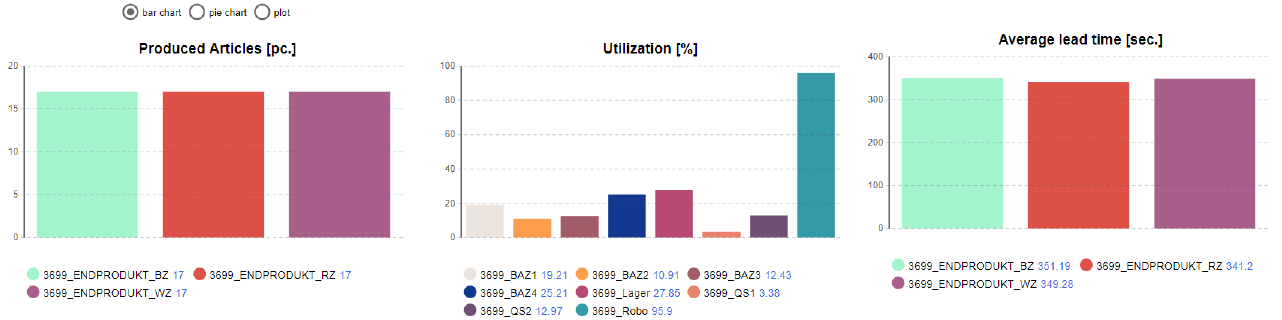
Figure 10. Statistical analysis with three example diagrams.